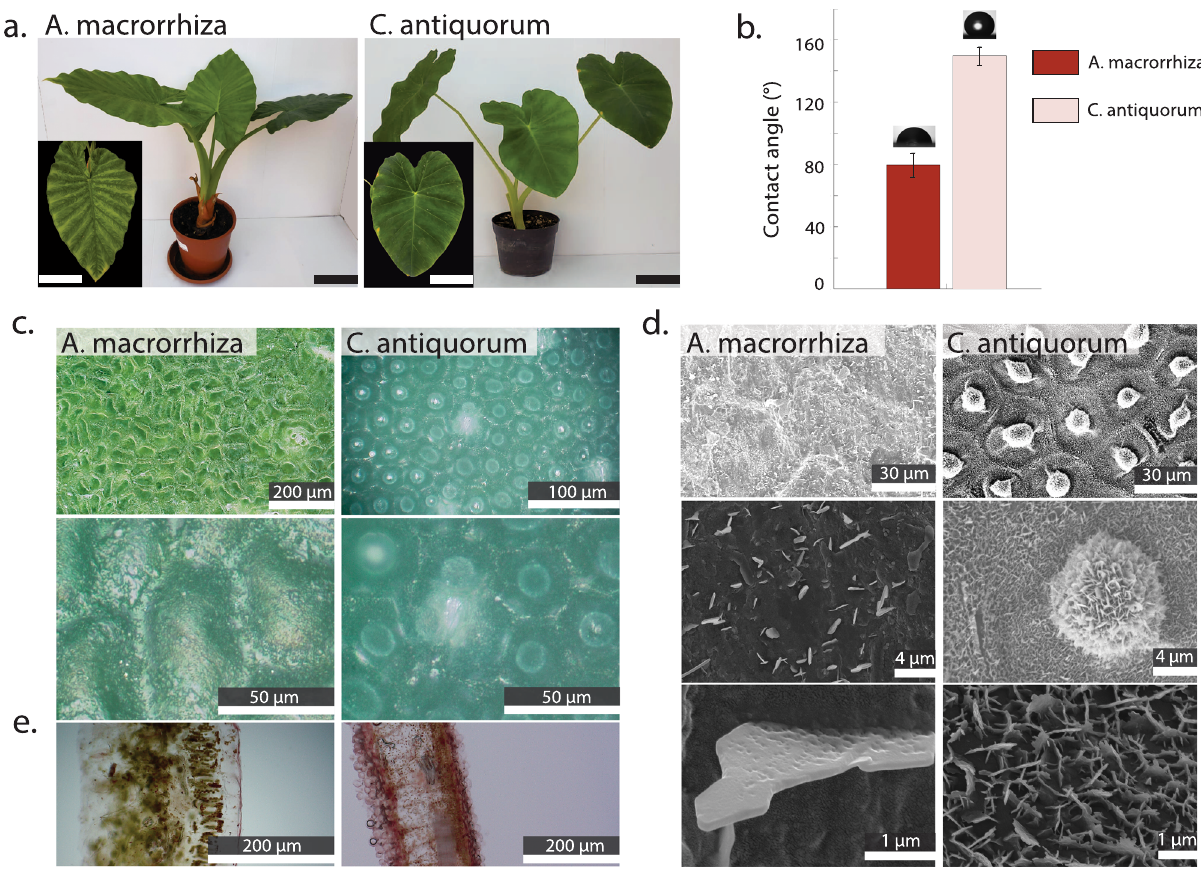
Fig. 1 Characteristics of model species A. macrorrhiza and C. antiquorum . a Photographs of A. macrorrhiza and C. antiquorum , insets are top view images of the leaves. All scale bars are 10 cm. b Water contact angle of both species measured at 0° inclination. Mean and standard deviation of fi ve measurements is given. c Digital microscopy of the adaxial side of the living leaf showing the surface and epidermal cellular structure. d SEM images of the adaxial leaf side at different magni fi cations showing the different distribution and density of surface wax crystals on both species. e Microscopy of leaf cross-sections of A. macrorrhiza and C. antiquorum and the cuticle speci fi cally stained in red (using Sudan IV). The stronger red color of C. antiquorum samples qualitatively con fi rm the larger number of stained